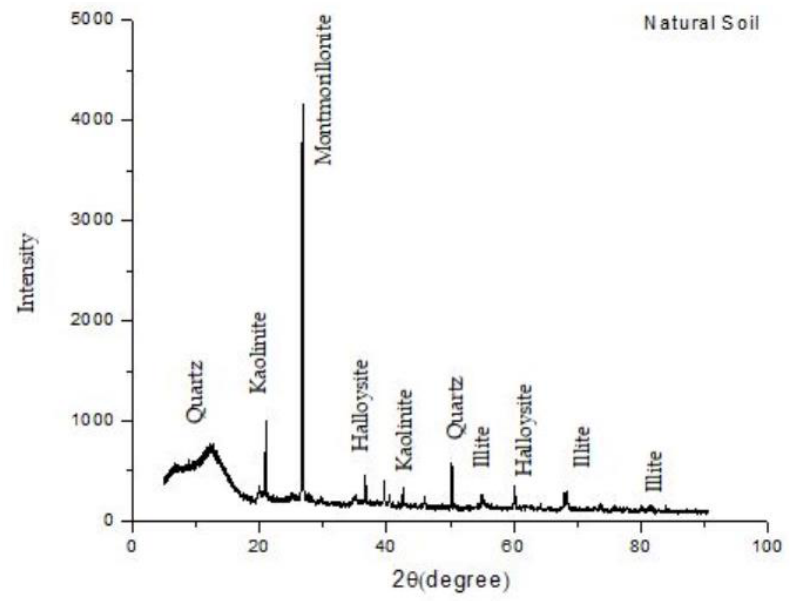
Figure 1. XRD pattern for marine clay soil.